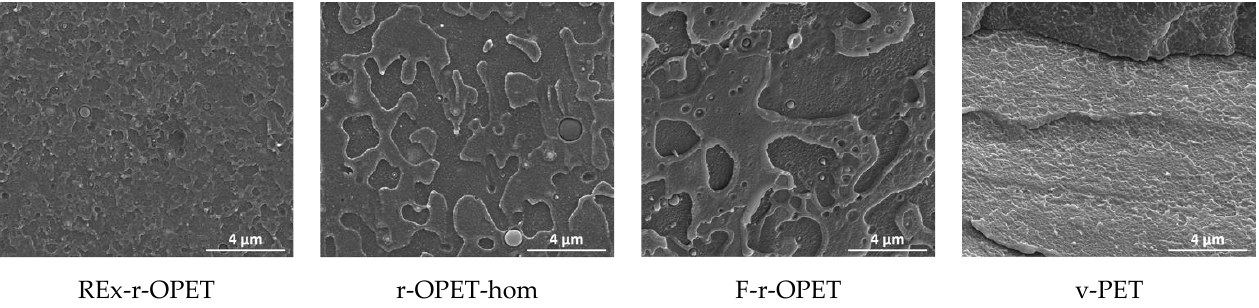
Figure 10. SEM images of cryogenic fracture surfaces of reference PET specimens (no fatigue).